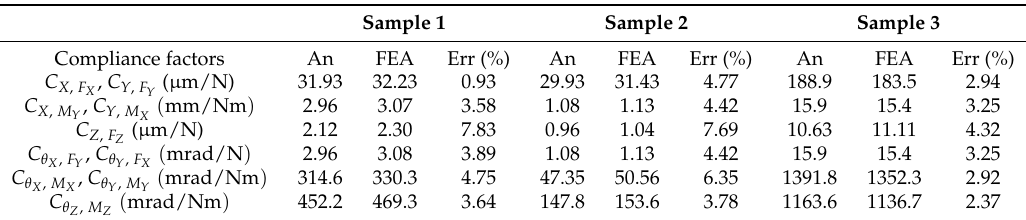
Table 2. Comparison of the compliance factors between analytical (An) and Finite element analysis (FEA) results. Sample 1 Sample